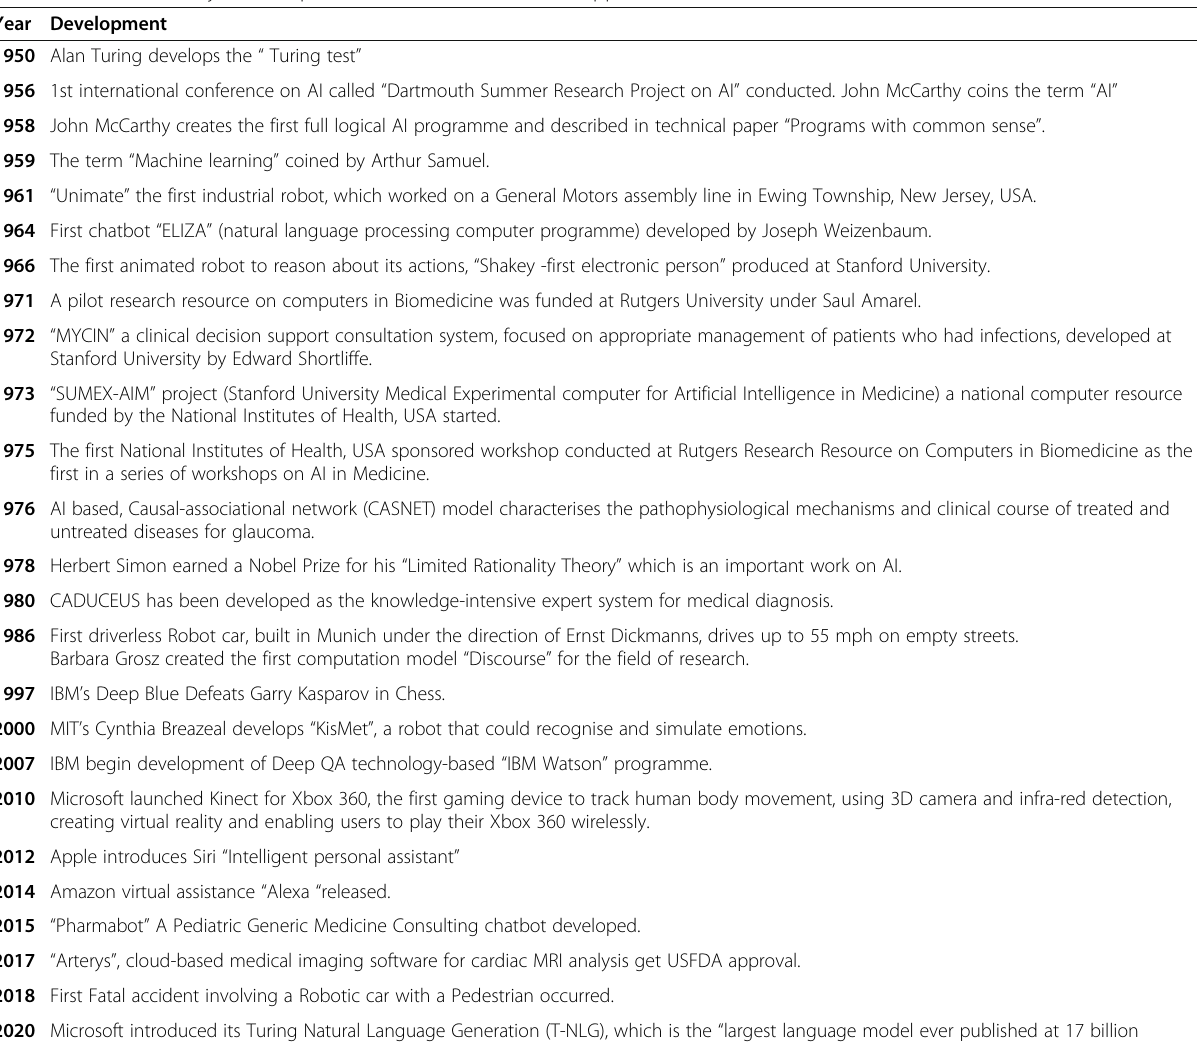
Table 1 Timeline of major development in AI field with medical